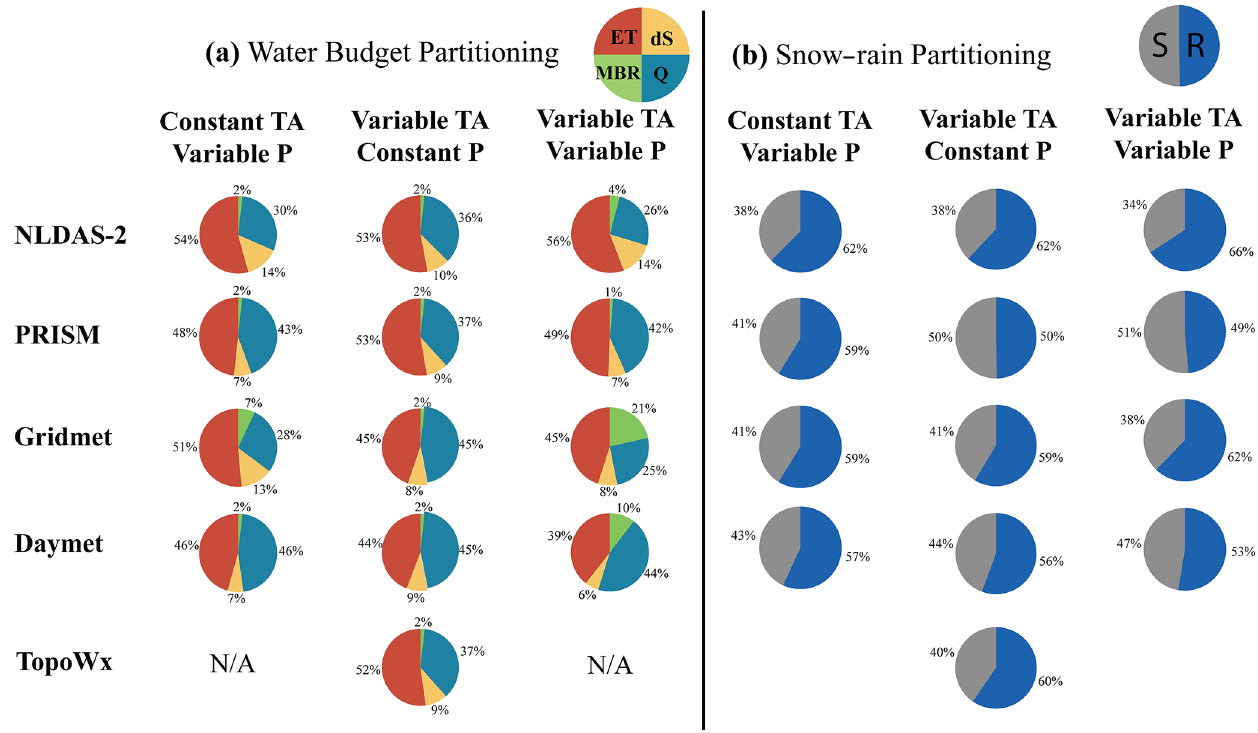
Figure 10. (a) Water budget partitioning shown as a fraction of the incoming annual precipitation for the Kaweah Terminus watershed during WY2016 and (b) rain–snow partitioning in the Kaweah Terminus watershed for each of the scenarios in the three simulation experiments during WY2016. Fractions are rounded to the nearest